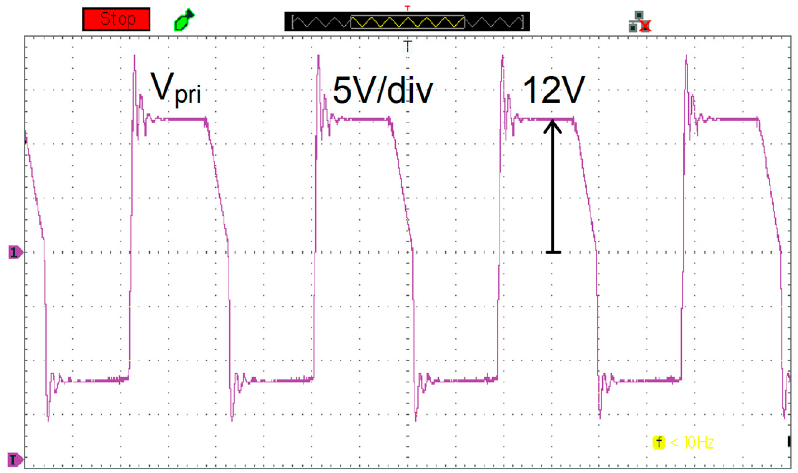
Figure 18. Output voltage of H-bridge and input to high-frequency transformer.